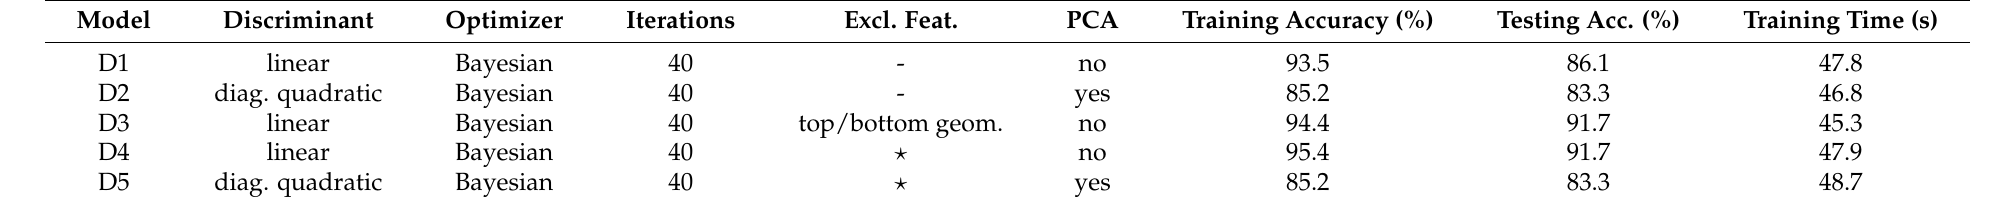
Table 8. Features of the DA models, and relevant accuracies achieved. Excl. feat. = excluded features ( (cid:63) = top/bottom geometry, diagrid total length, maximum normal